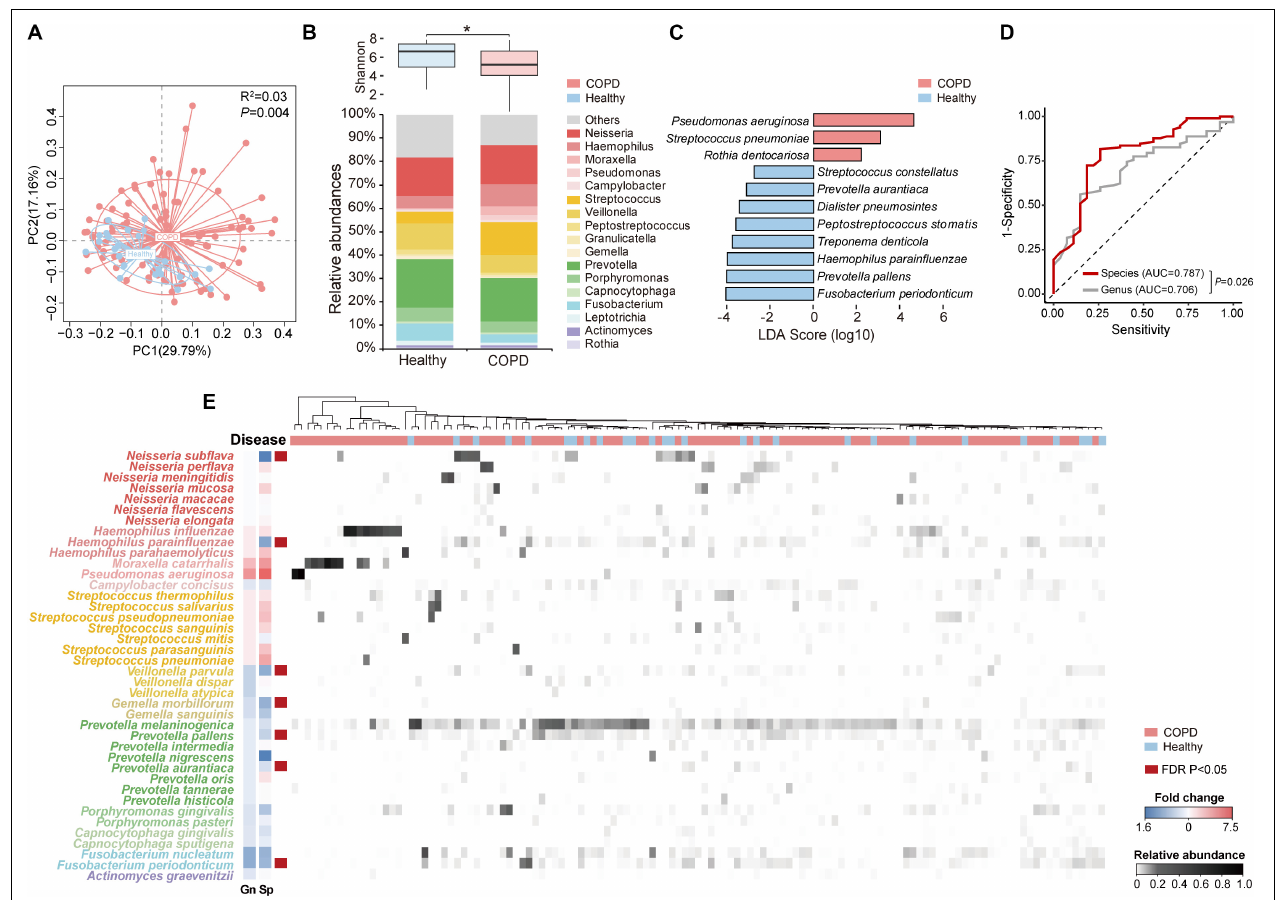
FIGURE 1 | The overview of species-level profile of the airway microbiome in COPD patients and healthy controls. (A) Principal coordinate analysis based on weighted UniFrac distance on sputum samples from 98 COPD patients and 27 healthy controls. (B) The Shannon diversity and relative abundances of major genera (relative abundance > 0.005) in COPD patients and healthy controls. (C) The 11 top discriminatory species-level taxa between COPD and controls as identified from LEfSe analysis (LDA > 2.0). (D) The receiver operating characteristic curves for the Random Forest analyses using the 11 species-level and 9 genus-level discriminatory taxa (LDA > 2.0) to segregate COPD patients from controls. (E) The heatmap for the species-level microbiome profile. The major species-level taxa (relative abundance > 0.001) within each genus in panel (B) were shown. The fold change of each species (Sp) and its corresponding genus (Gn) in COPD patients versus controls were shown beside the taxonomy. * Wilcoxon test, P <